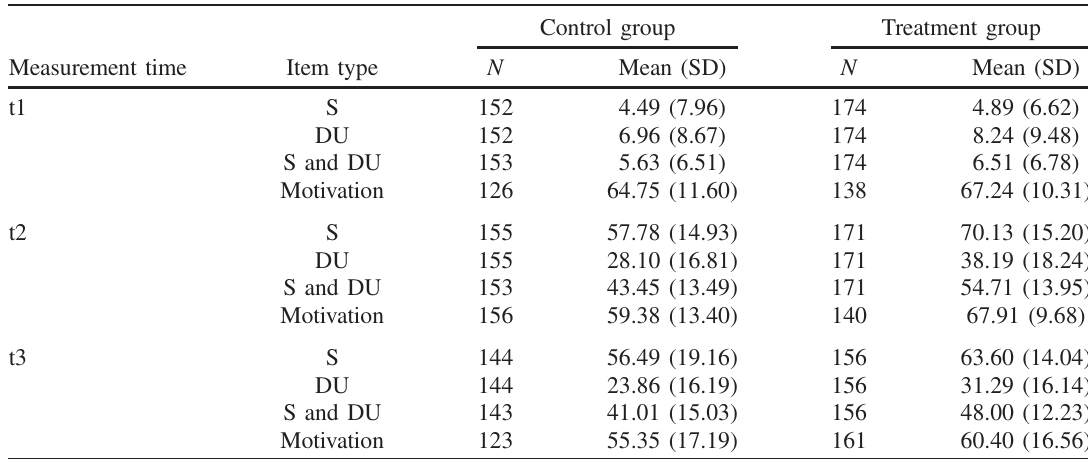
TABLE III. Descriptive values (averages and standard deviations in percent of max. score) for S (standard) and DU (deeper understanding) assessment items separately and for the whole test, for motivation and for the different measurement times (t1: pre-intervention, t2: postintervention, t3: follow-up, 6 weeks after intervention).